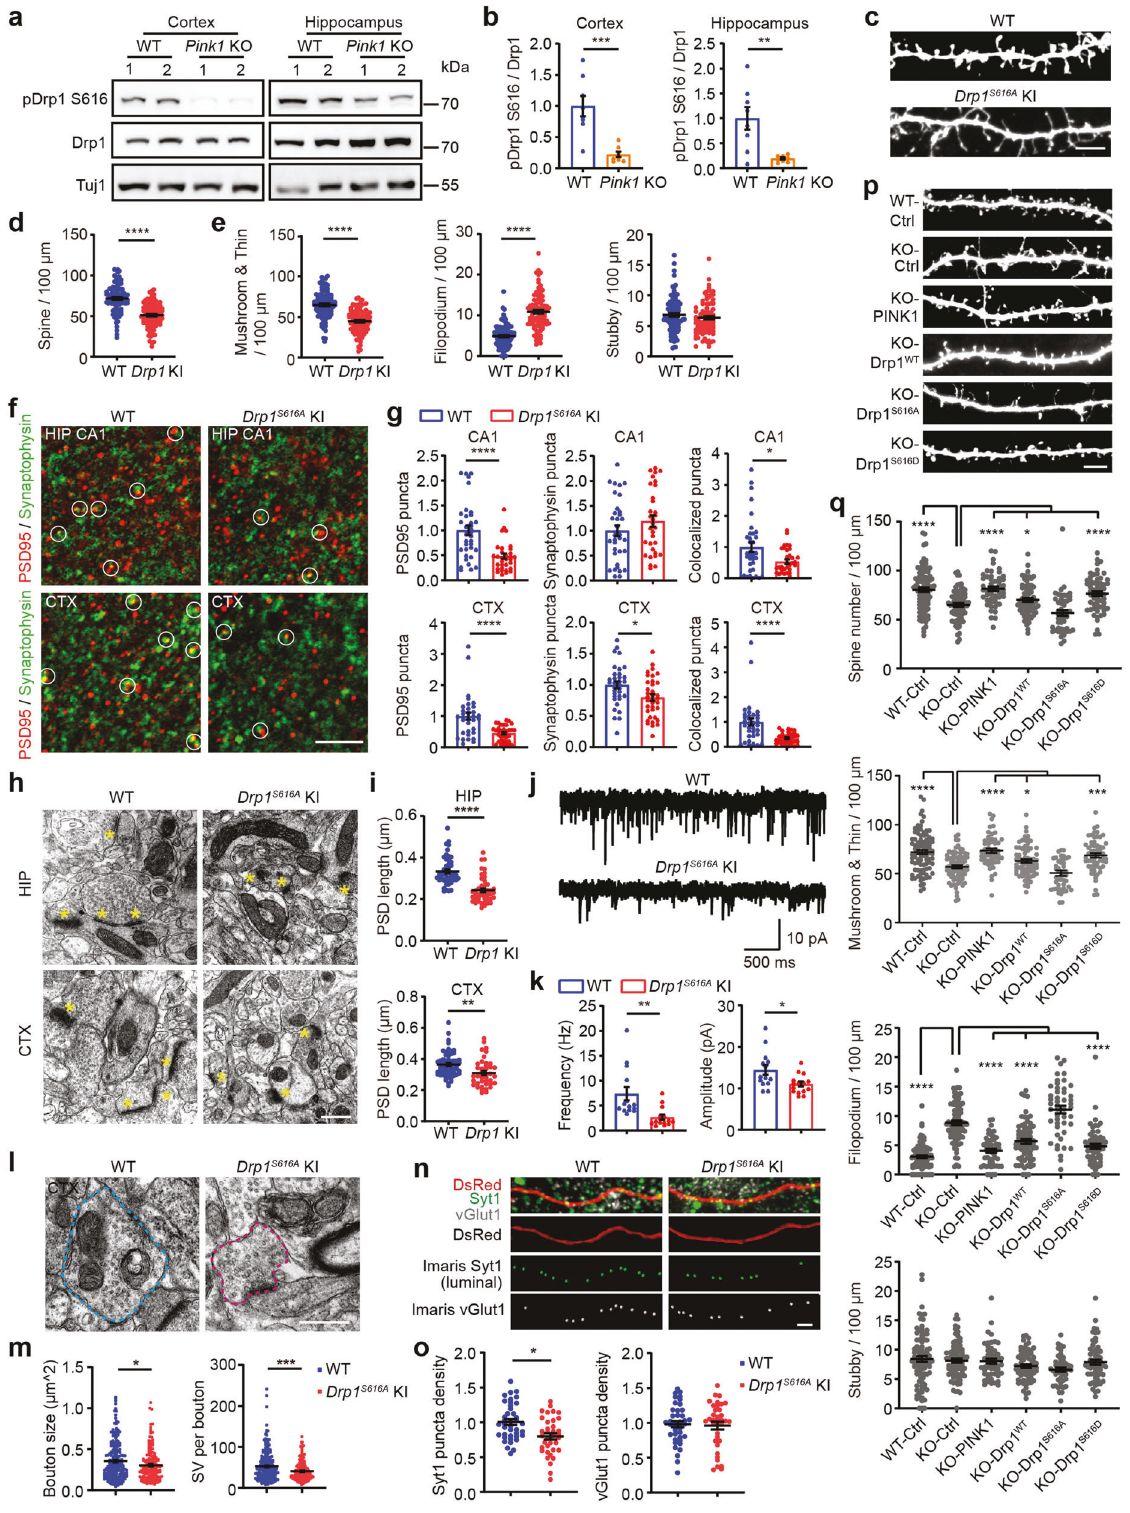
synapse/spine maturation via promoting Drp1 S616 phosphorylation-mediated mitochondrial fi ssion. We next test whether synaptic redistribution of mitochondria occurs upon LTP induction via the PINK1/phosphor-Drp1 S616 pathway. Cortical neurons (DIV 18) labeled by DsRed and